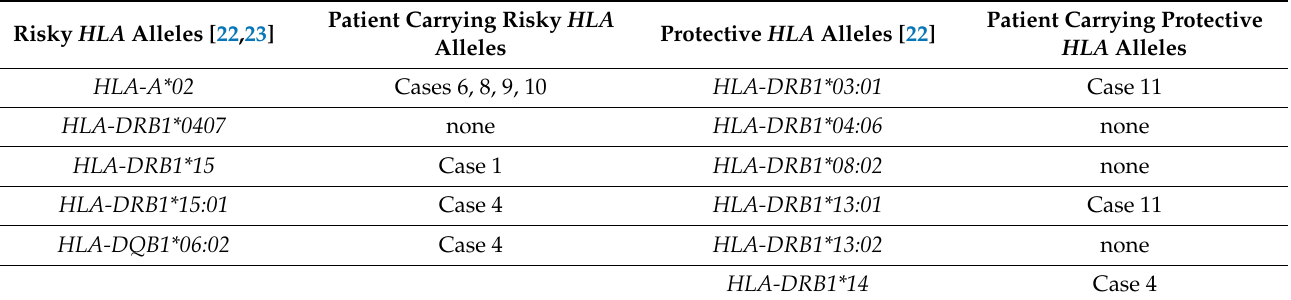
Table 2. AA-risky and-protective HLA alleles among 10 patients (Cases 1–2, 4,